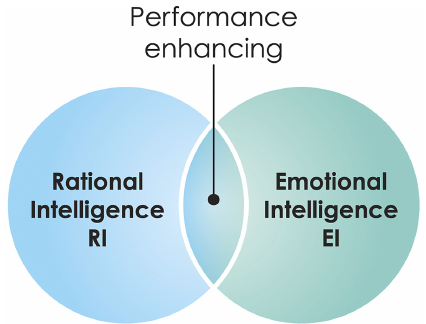
Figure 2. Creating